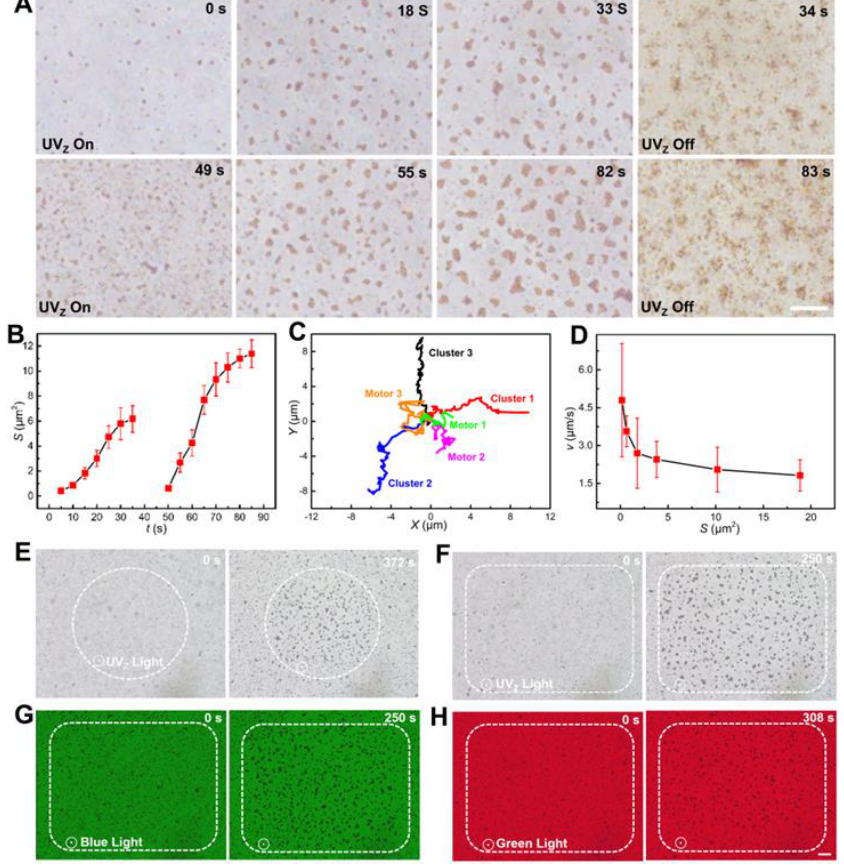
Figure 3. Swarming behaviors of the Fe 2 O 3 TNMs. ( A ) Time-lapse microscopic images of the Fe 2 O 3 TNMs depicting their reversible clustering behaviors in response to UV Z irradiation ( I = 513 mW/cm 2 ). The scale bar is 10 μm. ( B ) Corresponding changes of the cluster size ( S ) over time. ( C ) Motion trajectories of three typical single nanomotors and three nanomotor clusters. ( D ) The v of the clusters with different S . ( E , F ) Clustering of the nanomotors in a circular ( E ) and rectangular ( F ) UV Z light spot, respectively. ( G , H ) Clustering of the nanomotors in a rectangular spot of blue (480 nm) and green light (538 nm), respectively. The scale bar is 20 μm.